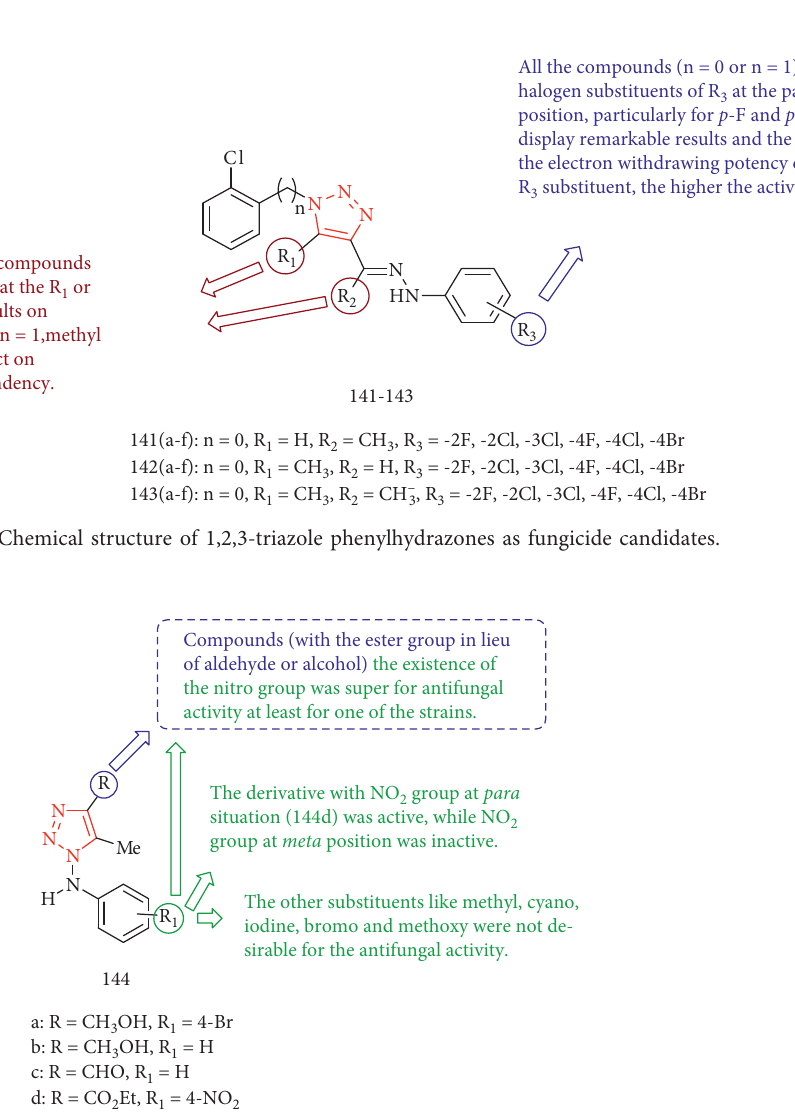
Figure 75: Chemical structure of N-substituted-phenylamino-1,2,3-triazole derivatives.